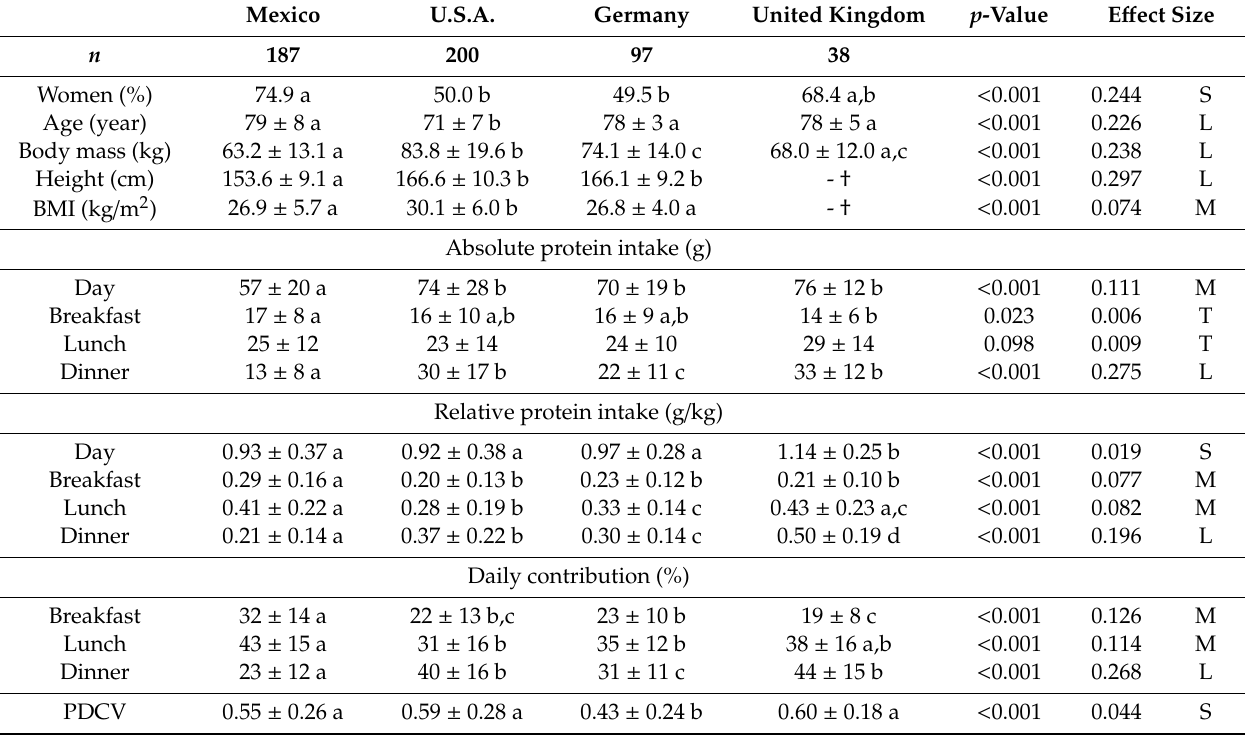
Table 2. Participants’ main characteristics and protein intake variables by